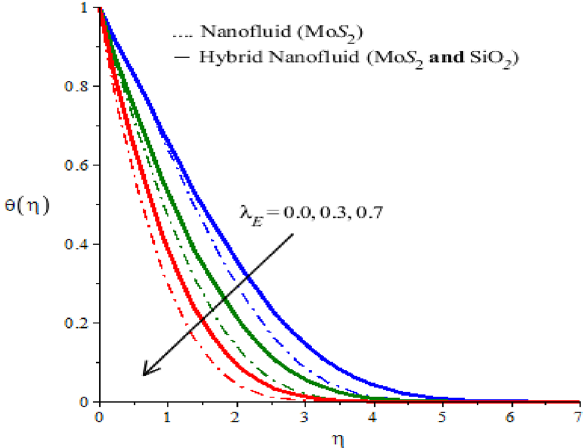
Figure 8. Temperature profiles of mono nanofluid (dotted curves) and hybrid nanofluid (solid curves) for (cid:31) E when Pr = 204, (cid:31) E = 2.4, h s = 1.7, n = 2, M = 0.001, φ 1 = 0.004, φ 2 =